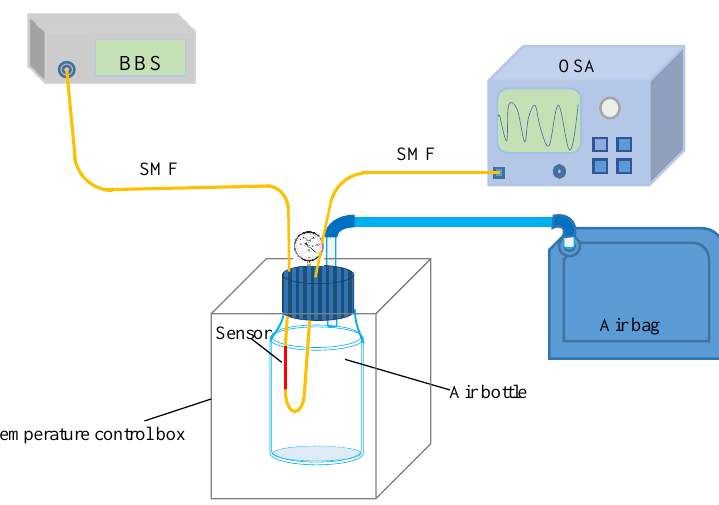
Figure 4. The schematic diagram of the alcohol vapor concentration sensing setup.